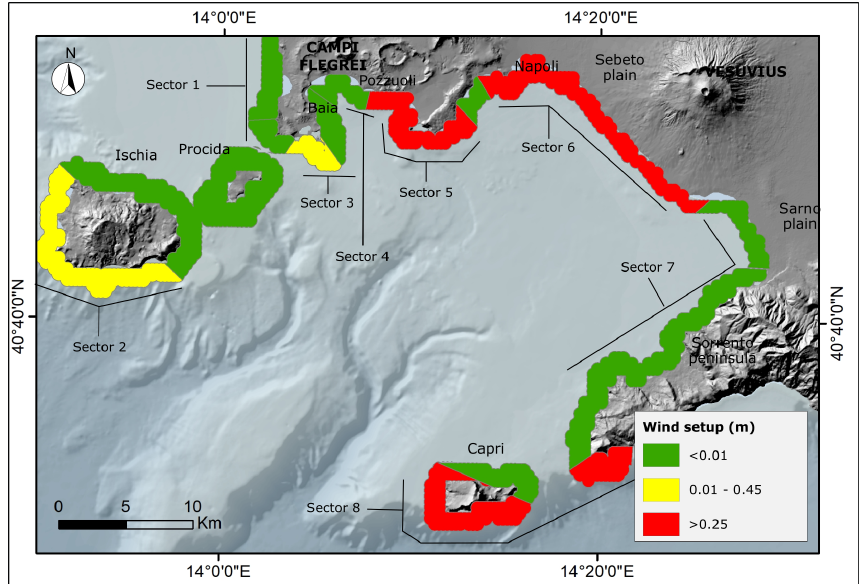
Figure 10. Wind setup along the coast of Gulf of Naples during t max . The DTM of the emerged area was downloaded from ISPRA webGIS (http://www.sinanet.isprambiente.it, last access: 1 February 2021); the DTM of the emerged area was downloaded from the GEBCO website (http://www.gebco.net, last access: 1 February 2021).